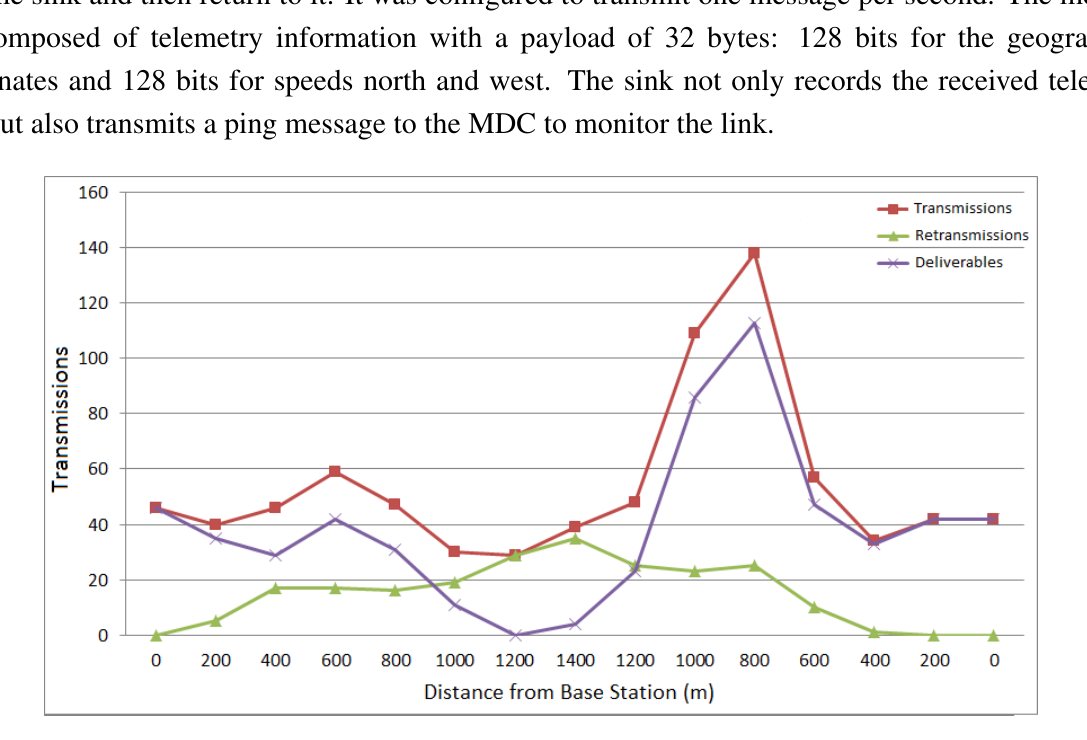
Figure 8. data collected from the reliable protocol